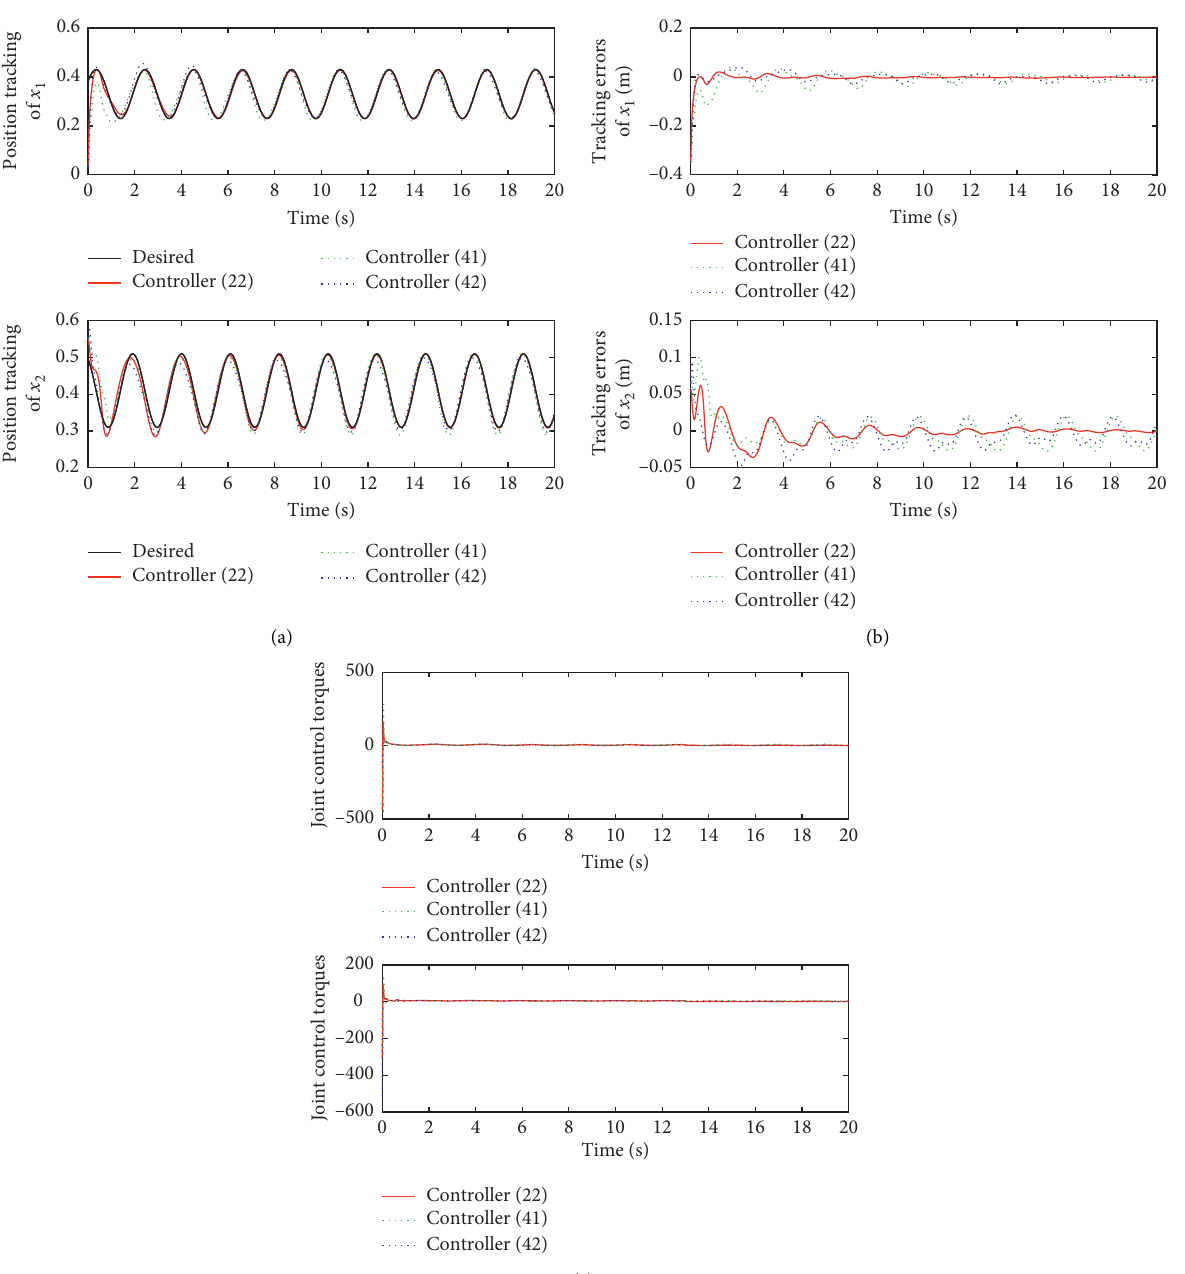
Figure 4: Comparisons of end-effector position tracking performance. (a) Comparisons of tracking performance. (b) Comparisons of tracking errors. (c) Comparisons of control torques.